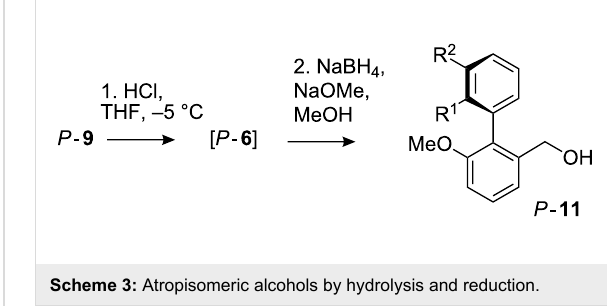
Scheme 3: Atropisomeric alcohols by hydrolysis and reduction.